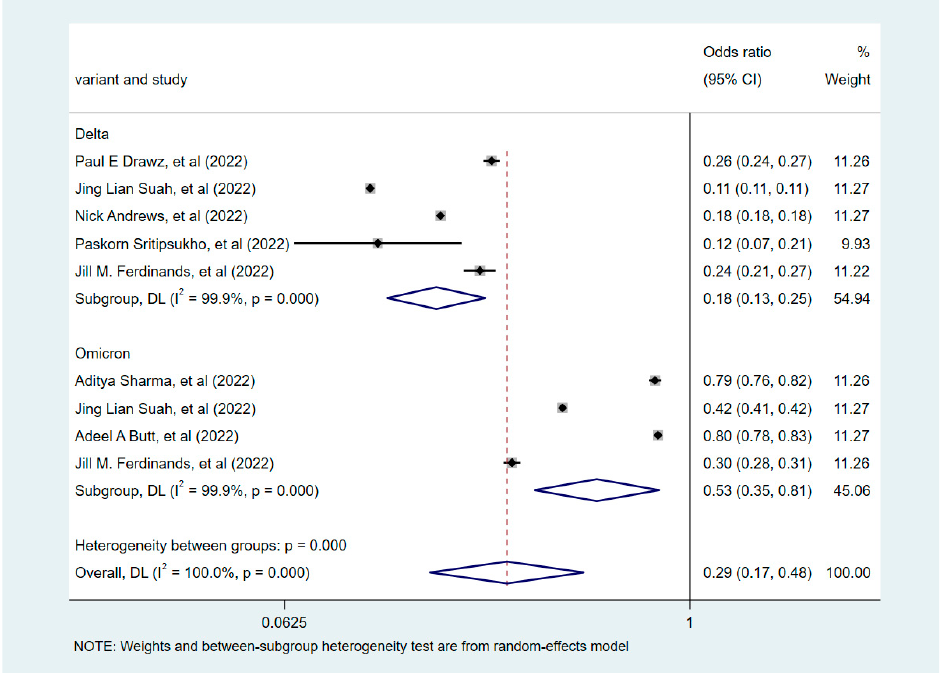
Figure 2. Forest plots showing pooled risk ratio of COVID-19 vaccine booster shots associated with infections.